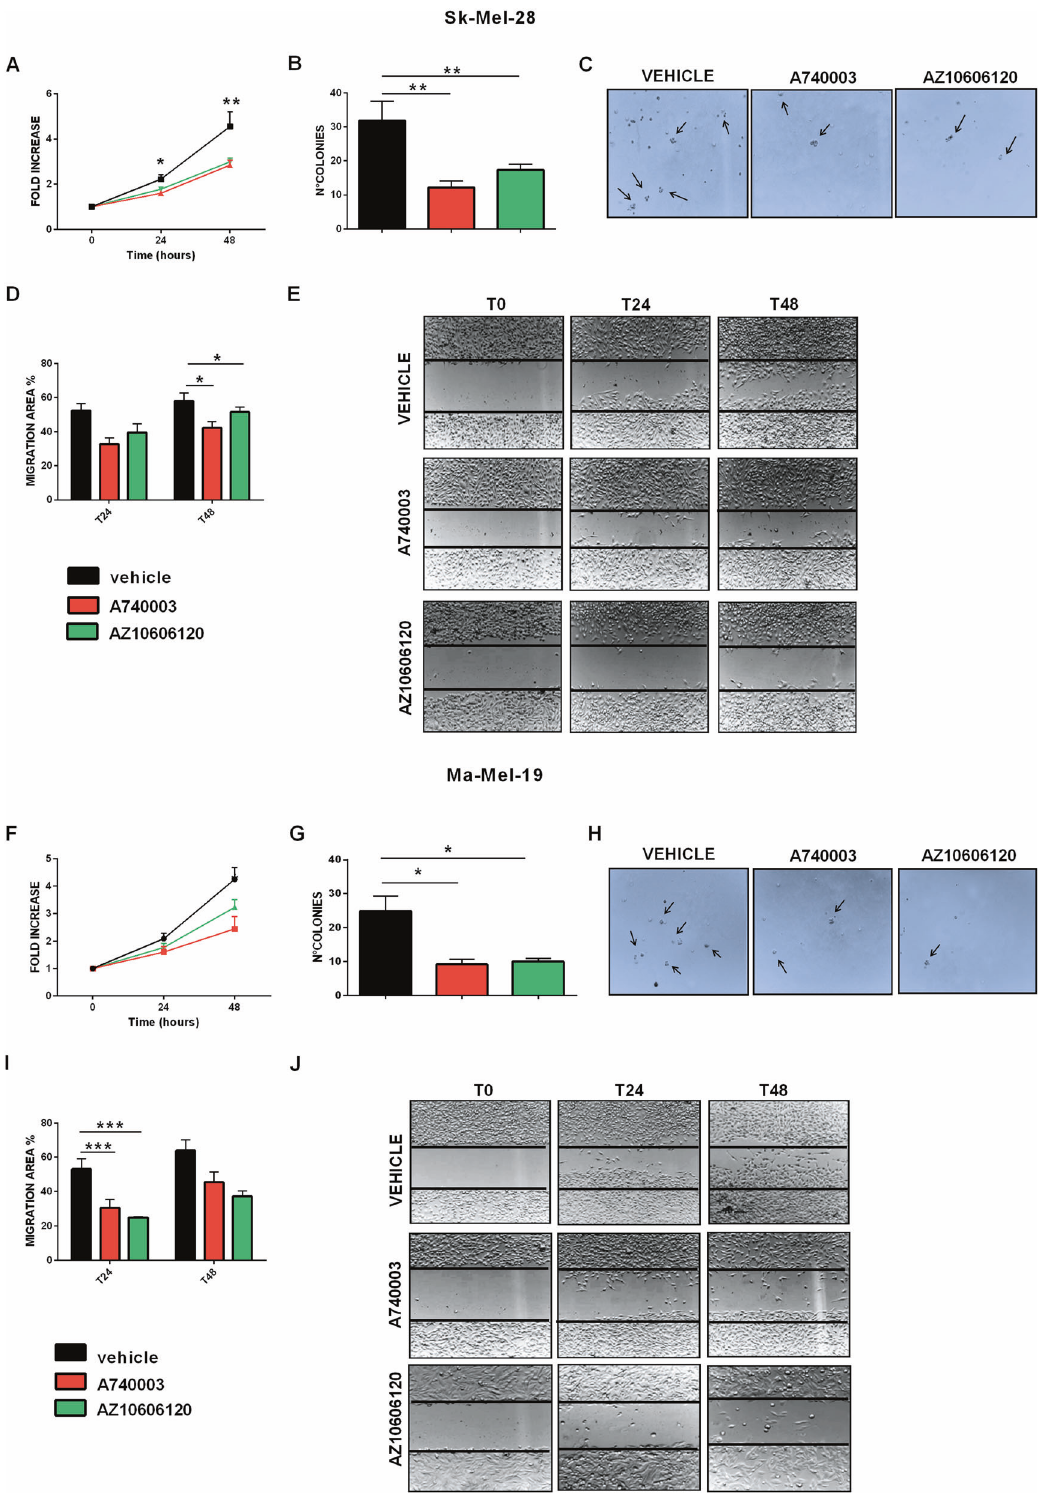
ATP stimulation, shows a different global miRNA expression pro fi le (Fig. 7A – D). On a total of 2553 miRNAs analyzed, P2X7R stimulation caused differential expression of 251 miRNAs in Sk-Mel-28 EXO (98 up- and 153 down-regulated), of 193 miRNAs in Sk-Mel-28 MV (86 up- and 107 down-regulated), of 91 miRNAs in Ma-Mel-19 EXO (55 up- and 36-down regulated), and of 206 miRNAs in Ma-Mel-19 MV Cell Death and Disease (2021)